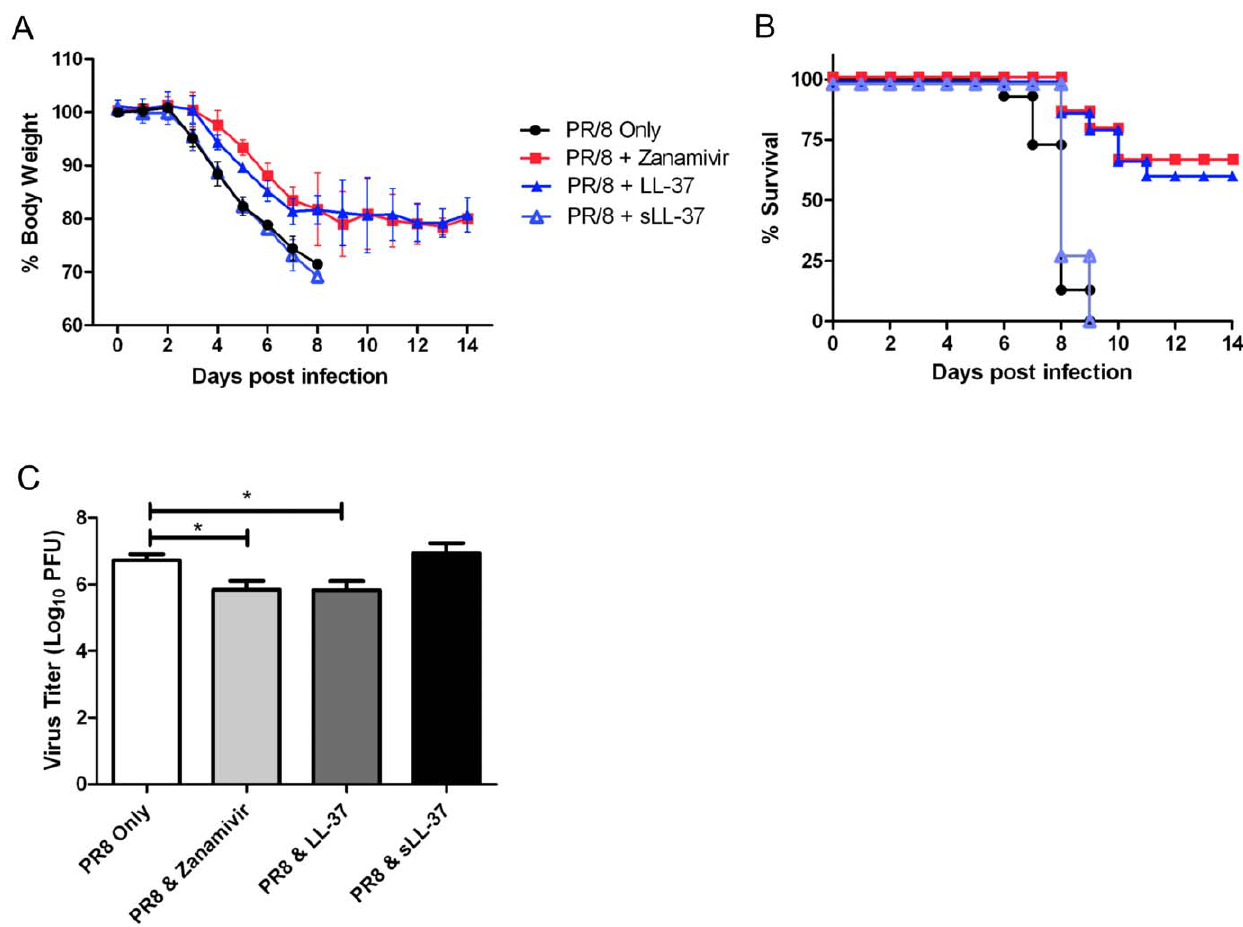
Figure 1. LL-37 Protects Mice Against Influenza Virus Disease. (A,B) Groups of 5 mice were inoculated with 10 MLD 50 of A/Puerto Rico/8/1934 influenza virus by the intranasal route on day 0. Mice were nebulized with 200 m l of saline (control), zanamivir (500 m g/ml), LL-37 peptide (500 m g/ml) or scrambled LL-37 control peptide (500 m g/ml) once daily from day -1 to day 7. Mouse body weight (A) and survival (B) was monitored daily up to 14 days post infection. Data represent mean values 6 SEM, for three independent experiments. Statistical analysis was performed using Kaplan Meier with a Mantel-Cox (log rank) test. Survival curves obtained with Zanamivir and LL-37 treatments were significantly different (P # 0.001) compared to saline control treatment. There was no difference between saline treated and sLL-37 treated groups. (C) Groups of three mice (Female, 6–8 week old Balb/c) were inoculated with 10 MLD 50 of A/PR/8/34 virus intranasally on day 0. Mice were nebulized with 200 m l of saline (control) zanamivir (500 m g/ ml), LL-37 peptide (500 m g/ml) or scrambled LL-37 control peptide (500 m g/ml) once daily from day -1 to day 2. Mice were euthanized on day 3 and viral titer in the lungs was assessed by plaque assay. Figure is representative of three independent experiments. Figure shows mean values 6 SEM. Statistical analysis was performed using a Student t-test to compare virus infected animals with virus/peptide and virus/zanamivir treated animals (*P # 0.05).